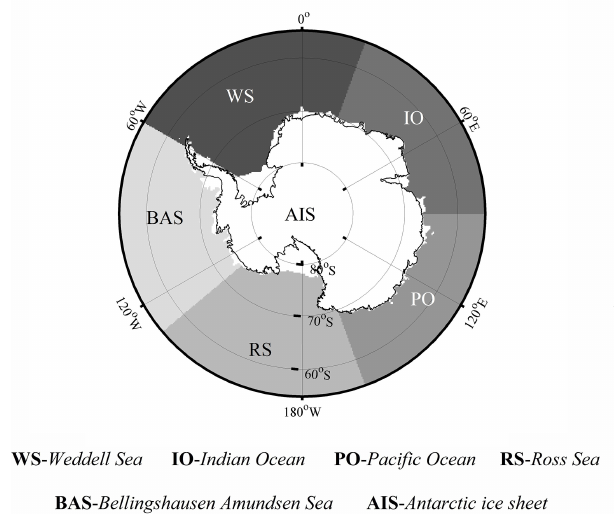
Figure 1. Map of the different regions across the pan-Antarctic re-